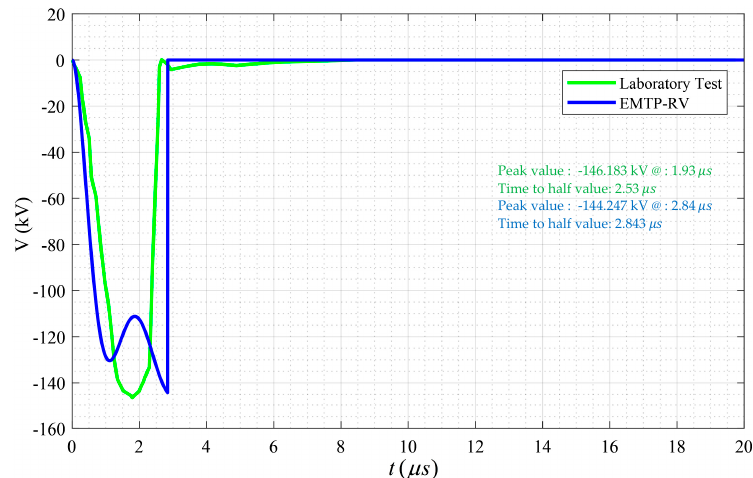
Figure 16. Applied impulse 125 kV in the presence of 119 µ H filtered spark gap, laboratory test and EMTP-RV model.